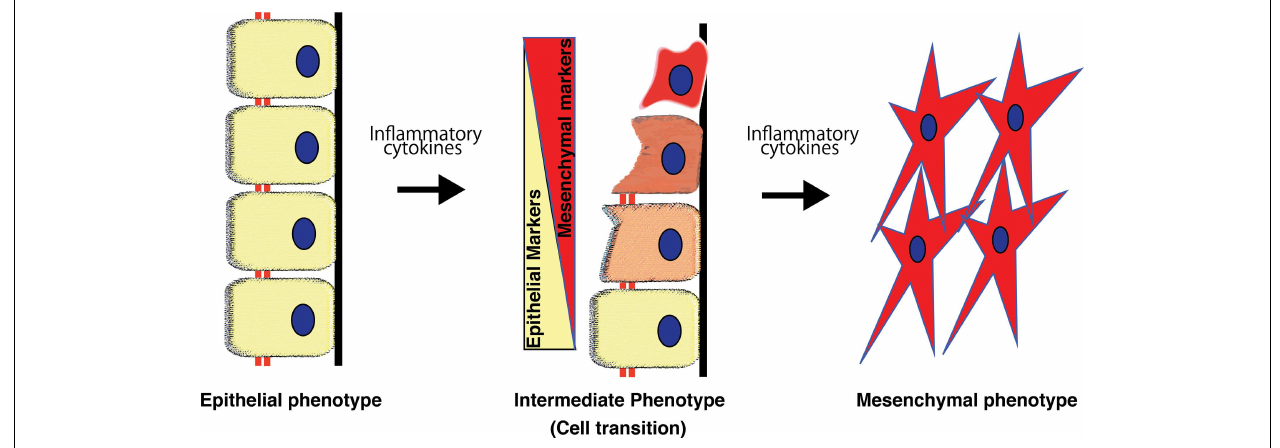
FIGURE 3 | Process of epithelial-to-mesenchymal transition. Epithelial-to-mesenchymal transition is a phenomenon that is well-orchestrated by inflammatory cytokines and results in epithelial cells gradually losing their cell markers and acquiring the mesenchymal phenotype.